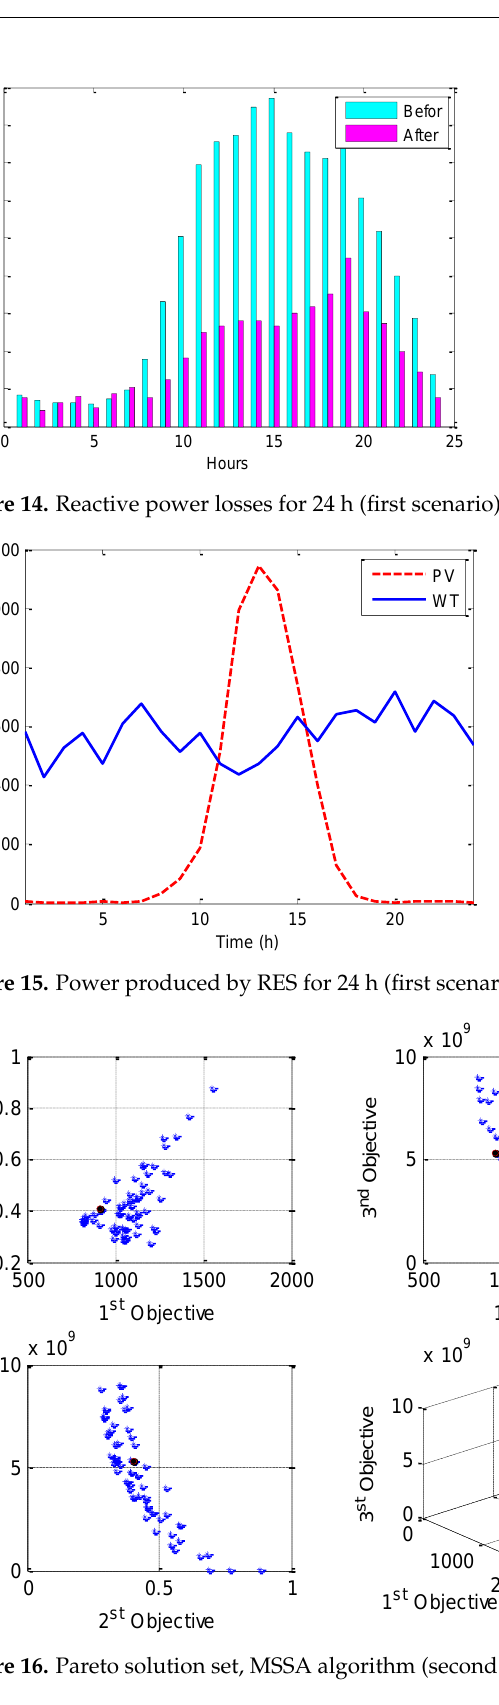
Figure 16. Pareto solution set, MSSA algorithm (second scenario).